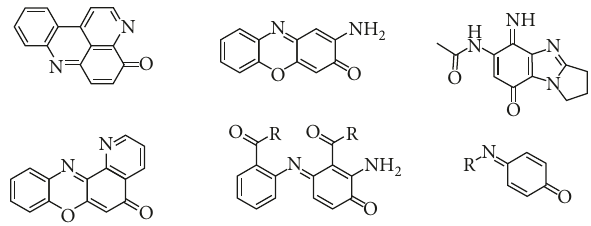
Figure 1: Bioactive molecules containing iminoquinone constitute the core structures.